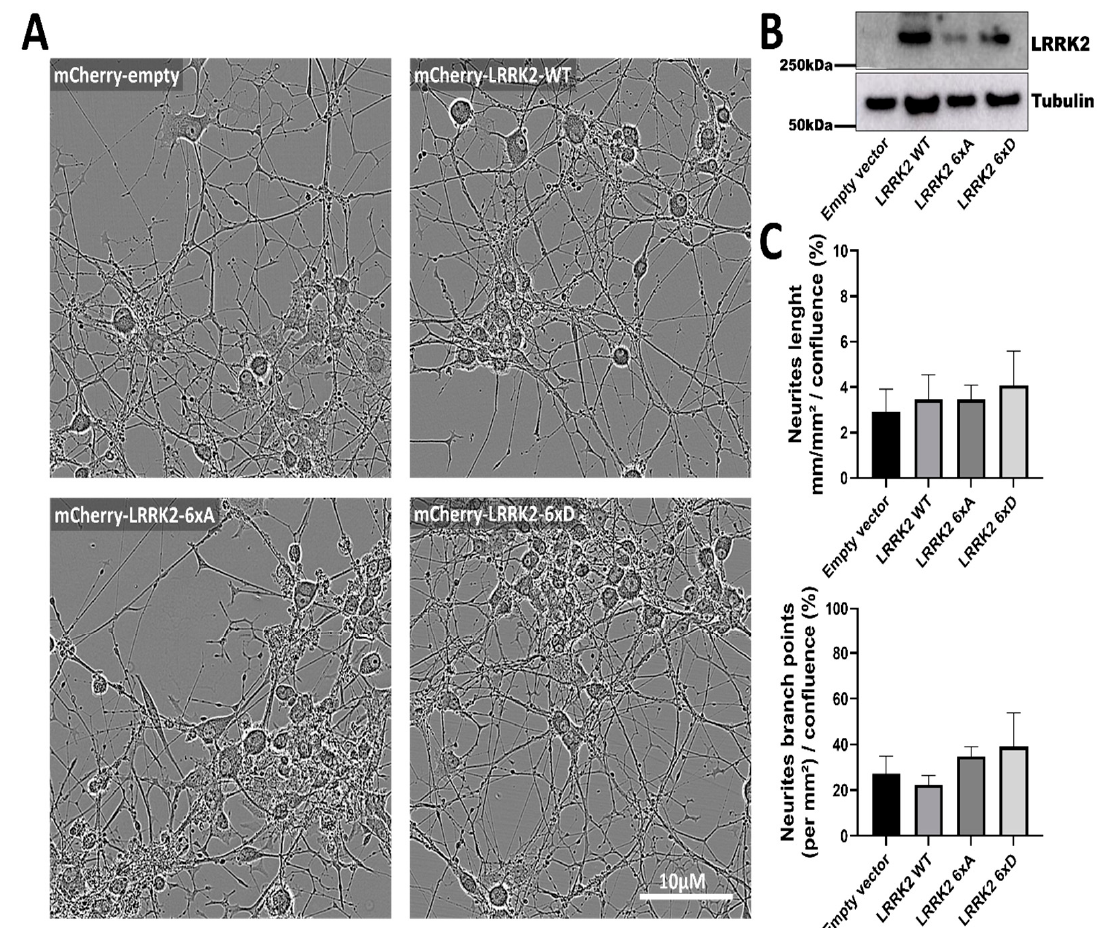
Figure 5. LRRK2 phosphorylation mutants do not affect NGF-induced neurite complexity in PC12 cells. PC12 transduced with mCherry-LRRK2 WT and phosphomutants are coated on P24 plate and differentiations are followed by live cell analysis ( A ). Expression of mCherry-LRRK2 was confirmed by Western blot analysis of cell lysates ( B ). Neurite length and neurite branch points were measured as described in the Materials and Methods ( C ).